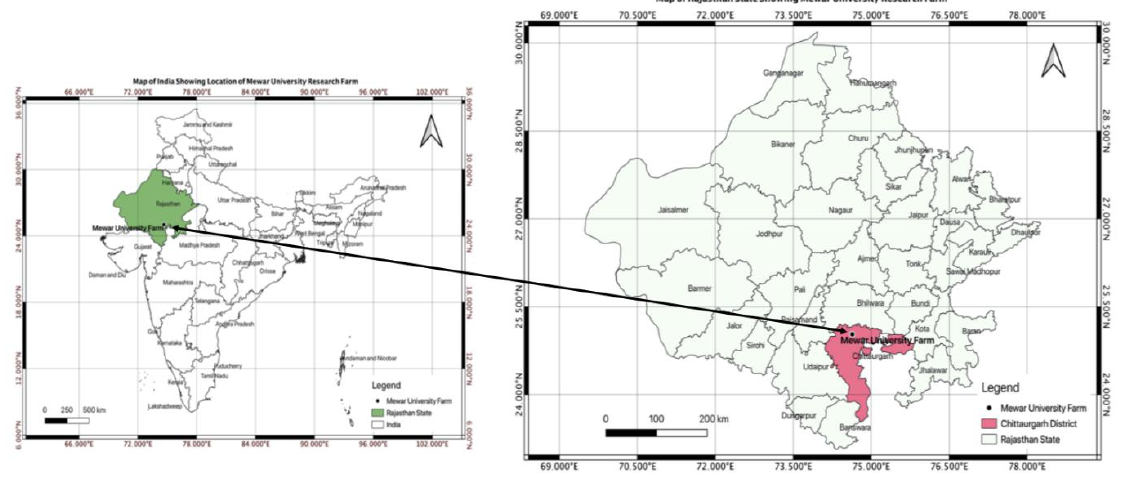
Figure 1. Map of India and Rajasthan state showing the study location Results and